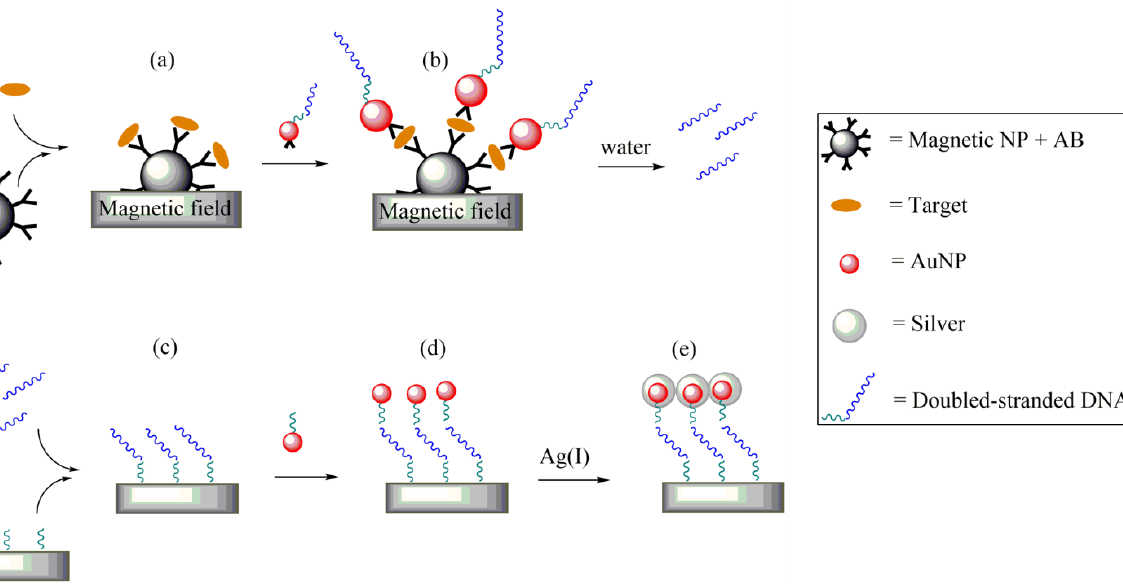
Figure 9. Functioning scheme of the AuNPs used in a bio-barcode. ( a ) Complex formed by a magnetic nanoparticle carrying specific antibodies and a target molecule, attracted on a magnetic substrate. ( b ) AuNPs bearing a double-stranded DNA and an antibody. ( c ) The double-stranded DNA washed away by water moves and interacts with a polynucleotide fixed to a chip. ( d ) Added AuNPs are functionalized by a complementary polynucleotide. ( e ) Finally, silver deposition allows the amplification of the detection signal.